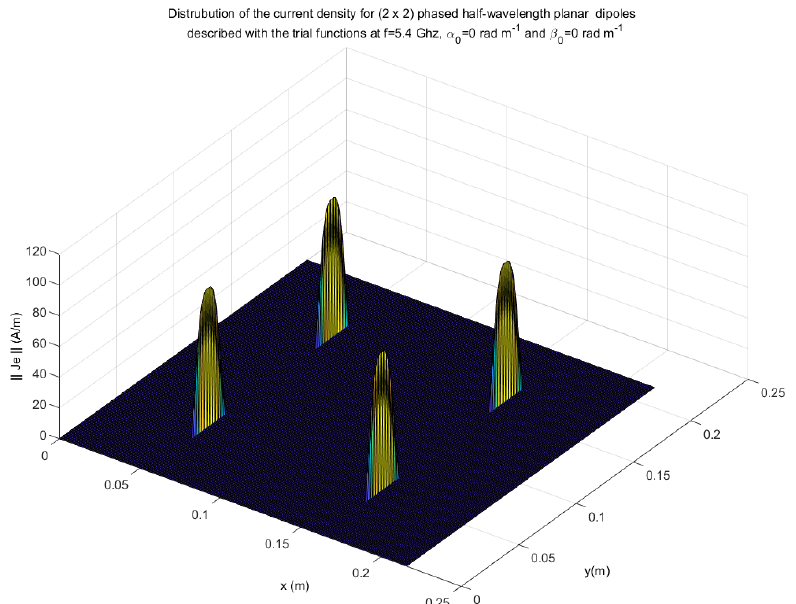
Figure 6. Distribution of the current density for (2 × 2) phased half-wavelength planar dipoles described with the trial functions (test functions) at f = 5.4 Ghz, α 0 = 0 rad m − 1 and β 0 = 0 rad m − 1 (MoM-GEC method) [18].